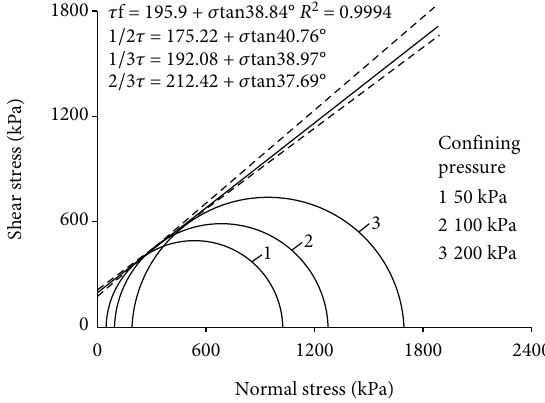
Figure 8: Mohr ’ s stress circles for triaxial tests of solidi fi ed soil samples with 0.6mol/L calcium chloride.